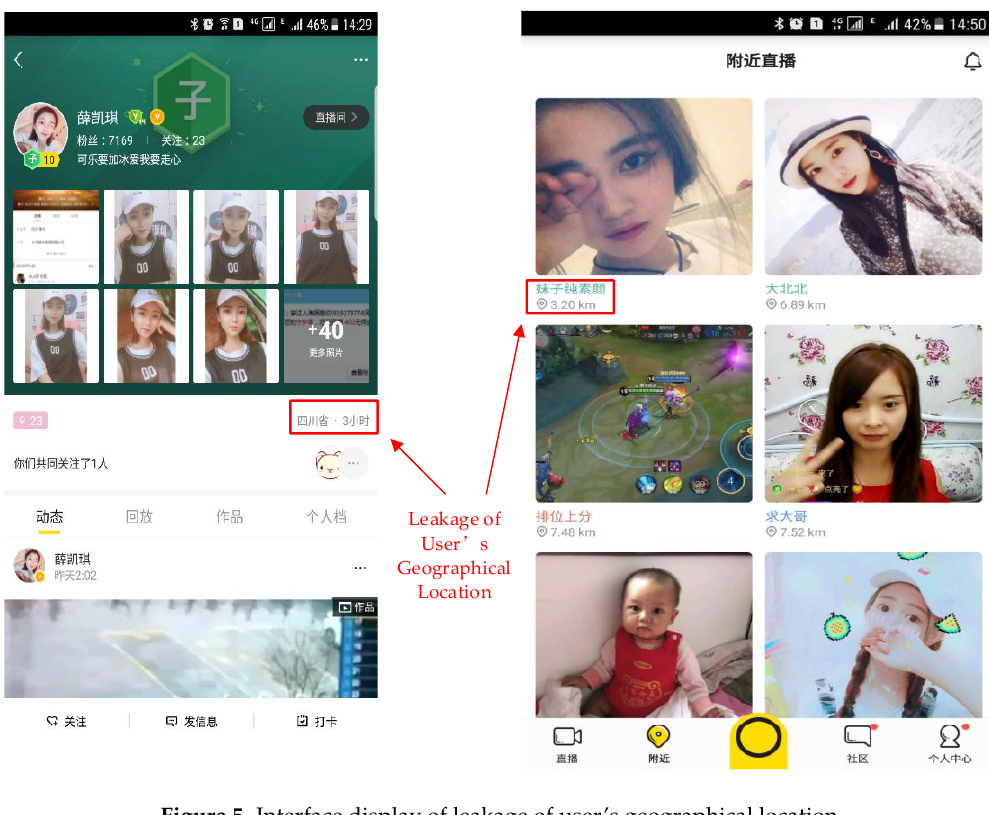
Figure 5. Interface display of leakage of user’s geographical location.